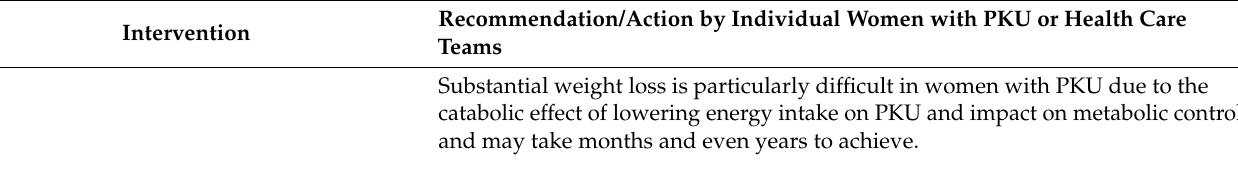
Prevention of overweightand